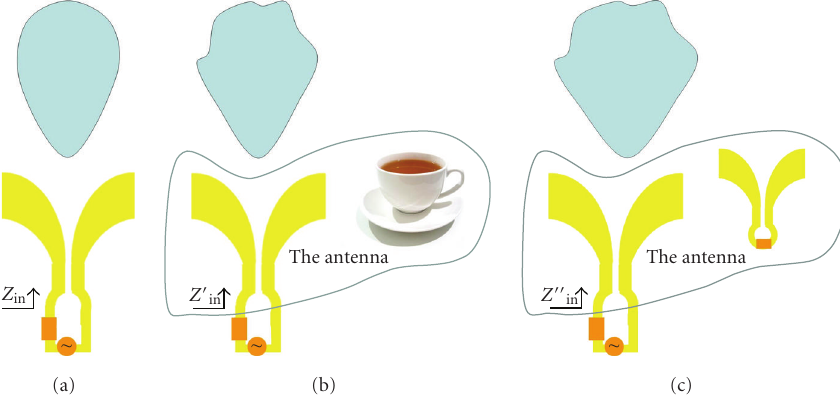
Figure 1: Mutual coupling between an antenna and an object located in its vicinity. E ff ects on radiation pattern and input impedance: (a) isolated antenna; (b) antenna with object in its vicinity; (c) antenna and other antenna in its